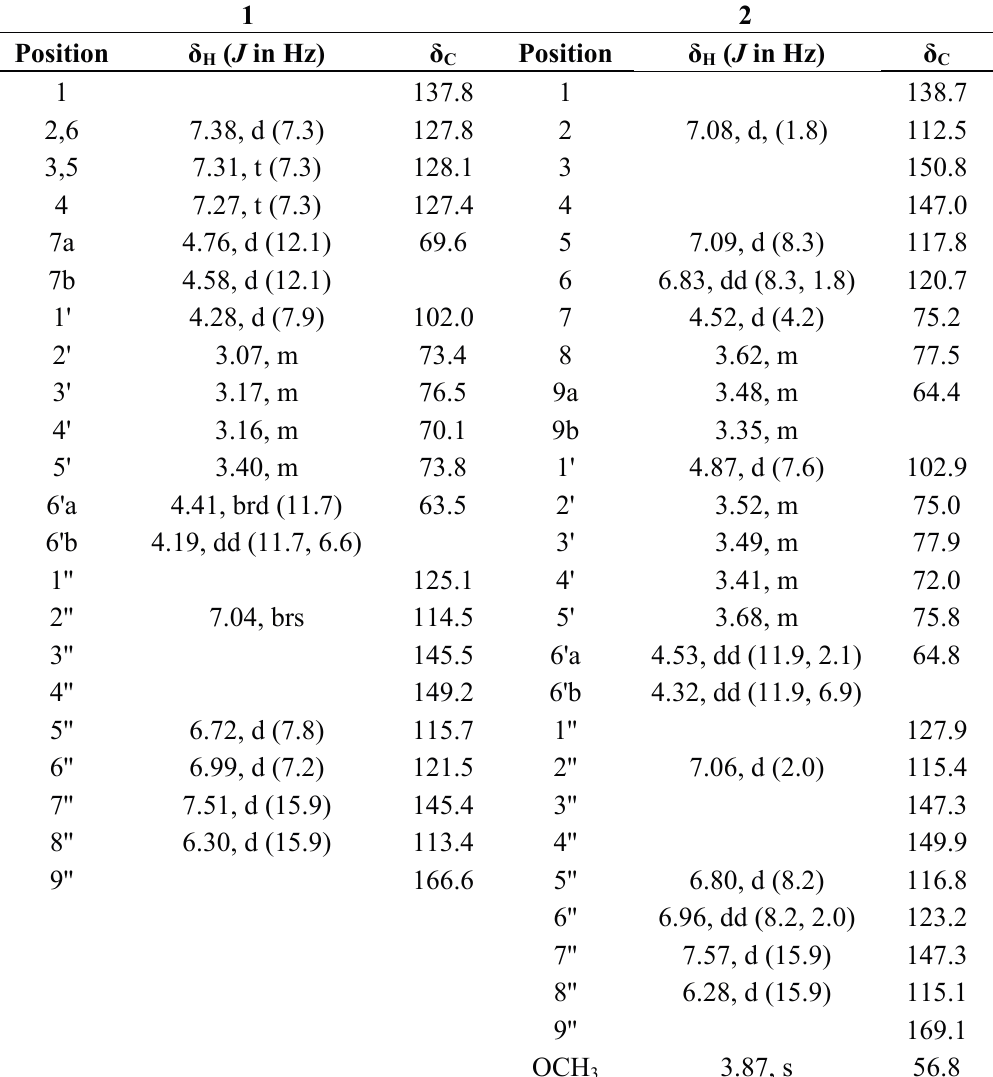
Table 1. 1 H- (500 MHz, δ ppm, J in Hz) and 13 C-NMR (125 MHz, δ ppm) of Compounds 1 and 2 in CD 3